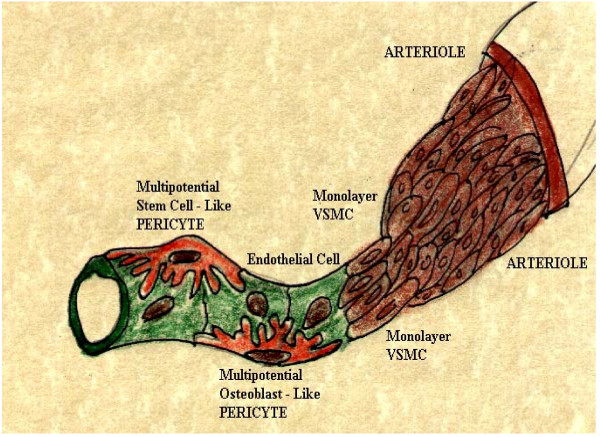
The multipotential, pluripotent (stem cell – like), and mesenchymal pericyte. The pericyte is considered to be a differentiated VSMC, which acts as guardian angel of the endothelial cell. It is capable of synthesizing most of the non-collagenous bone morphogenic proteins associated with VOC.